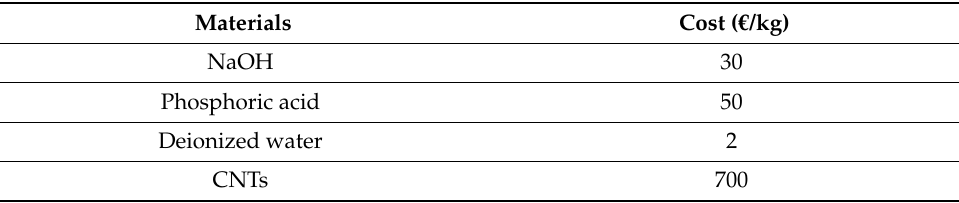
Table 7. Cost of